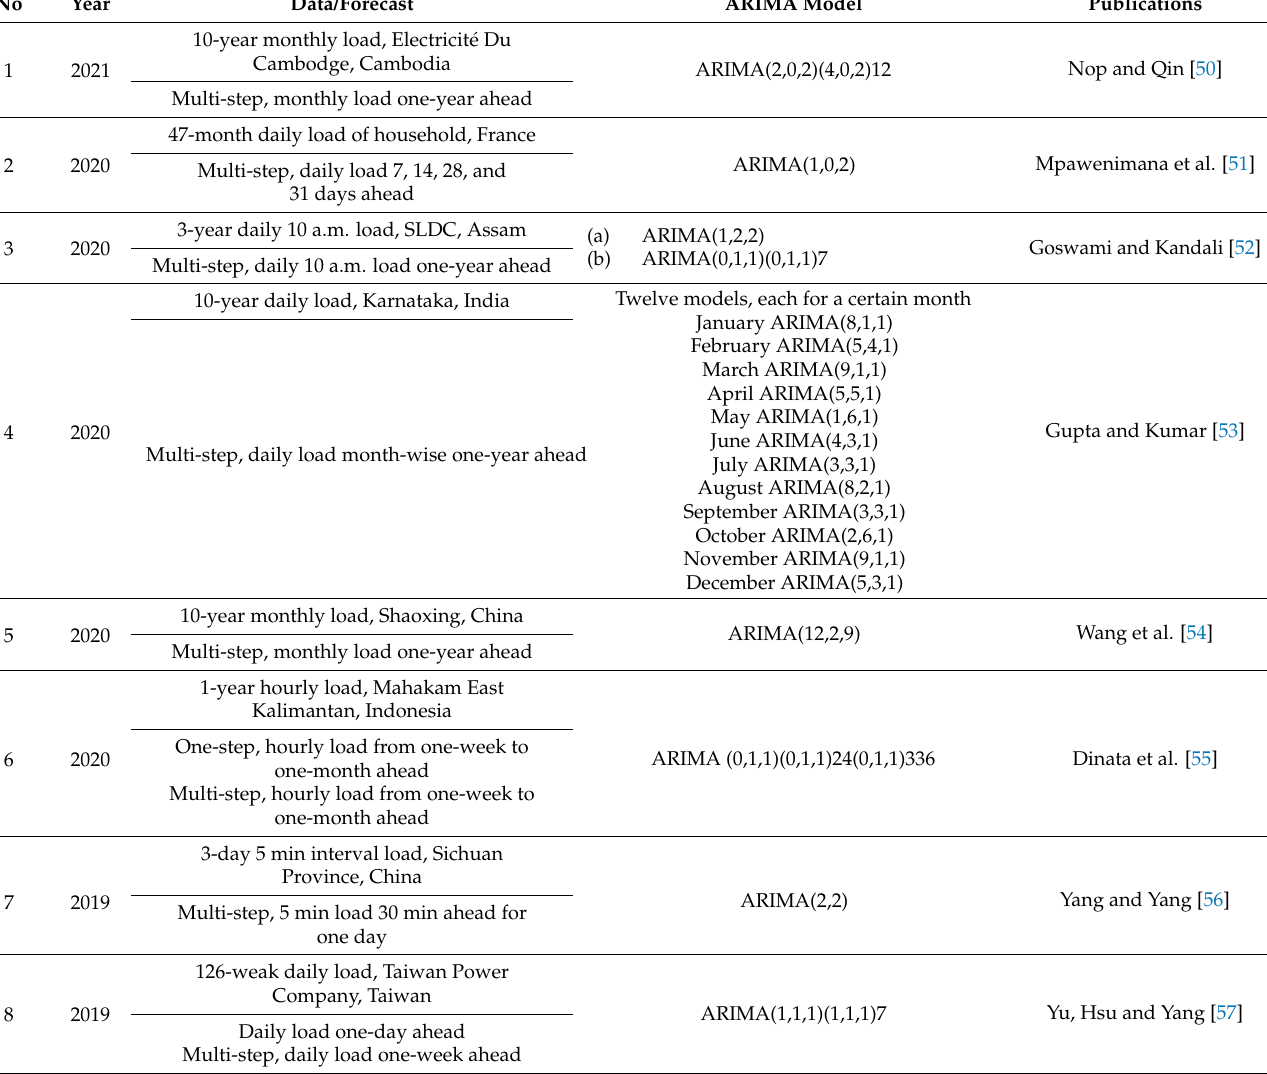
Table 2. Identified ARIMA models used in load